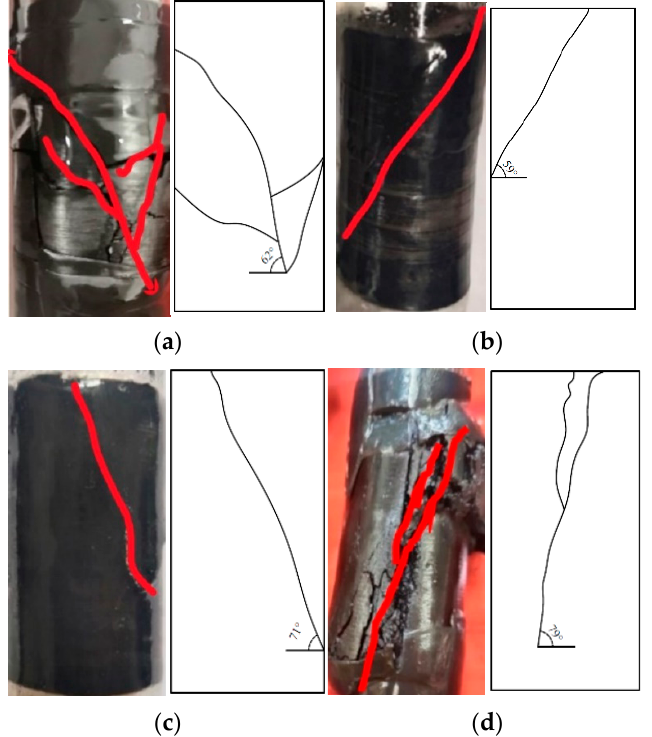
Figure 9. Failure patterns of triaxial compression test under different confining pressure. ( a ) 3 MPa. ( b ) 6 MPa. ( c ) 9 MPa. ( d ) 12 MPa.